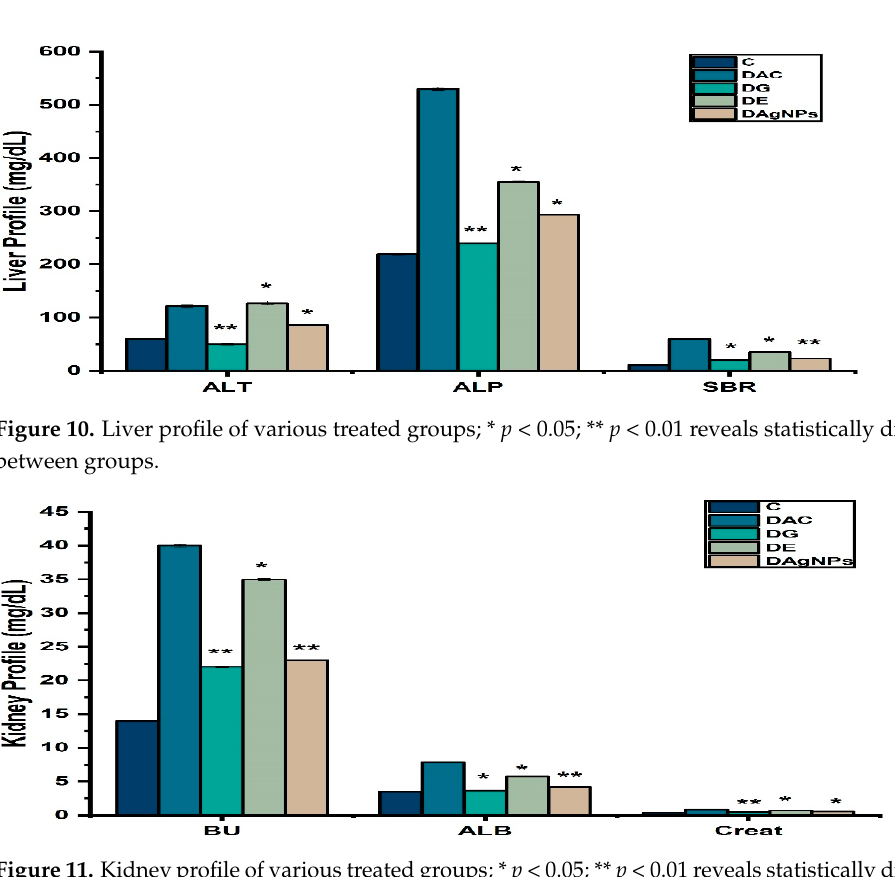
Figure 11. Kidney profile of various treated groups; * p < 0.05; ** p < 0.01 reveals statistically difference between groups. Table 2. Effect of methanolic extract and synthesized T. couneifolia AgNPs on urine analysis.